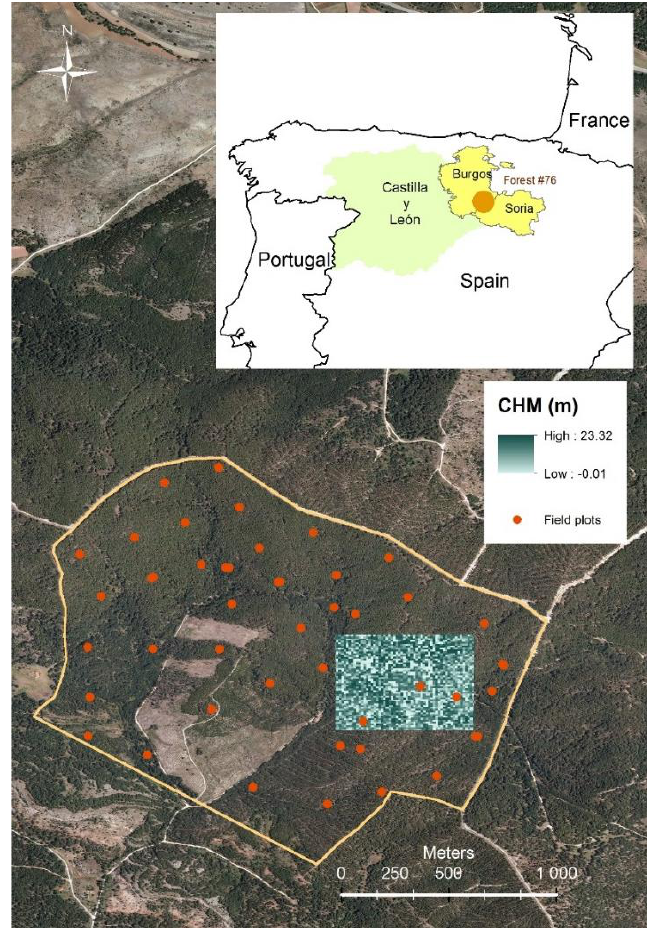
Figure 1. Location of the study area and field plots. A part of the study area is displayed as